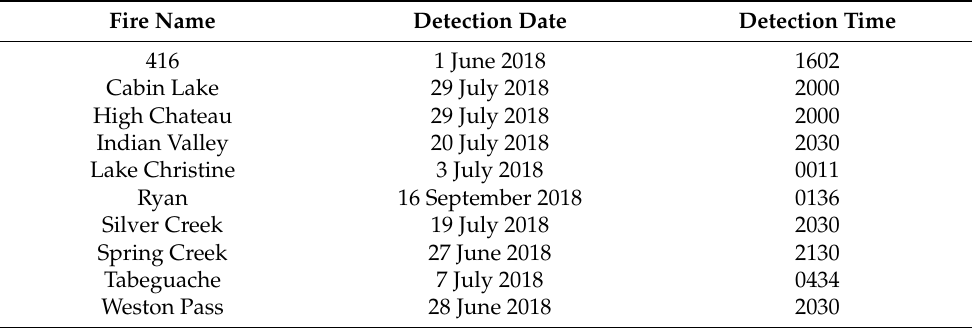
Figure 2. Ten Colorado wildland fire case studies from 2018, with initial detection locations (black dots). Initial detection locations for each case study were obtained from the Integrated Reporting of Wildland-Fire Information system [20]. Longitude (decimal degrees) and latitude (decimal degrees) showing the location of the fire case studies are given on the x-axis and y-axis, respectively. Table 1. Case study fire names, detection dates, and detection times